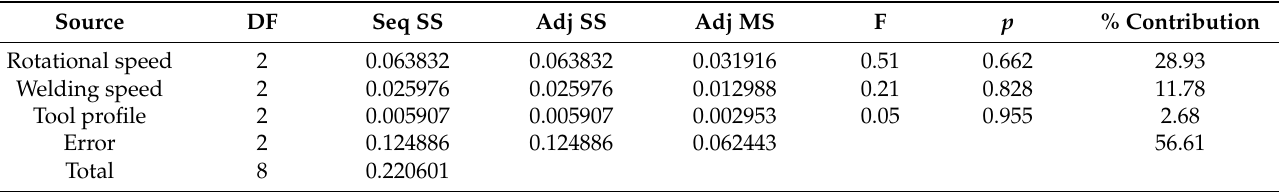
Table 11. Analysis of variance for the signal-to-noise ratios for